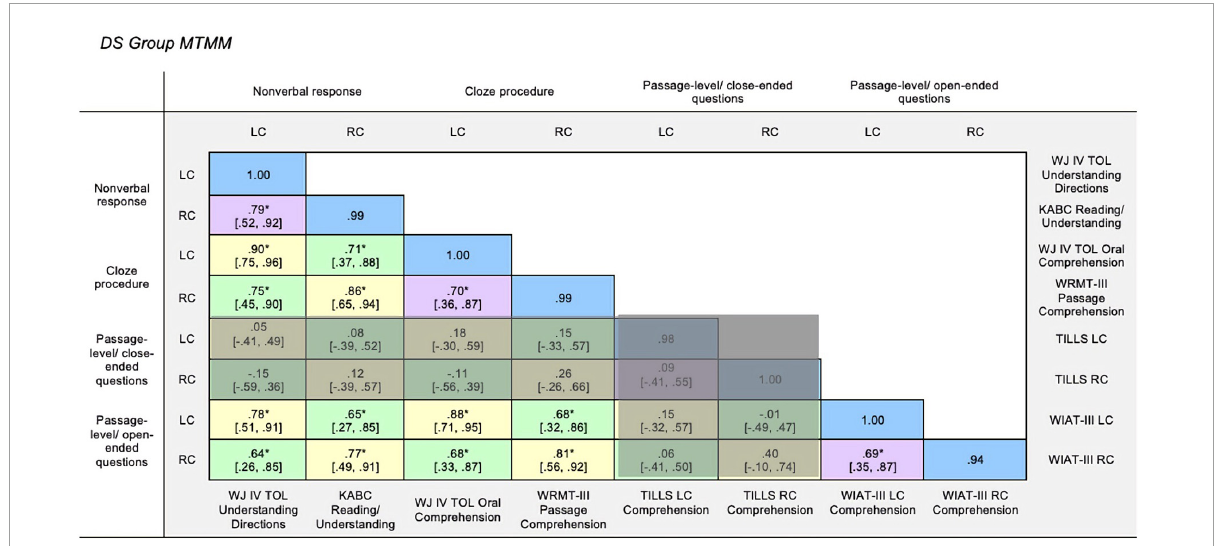
FIGURE1 DS group MTMM. Multitrait-multimethod matrix for Down syndrome group. Monotrait-monomethod cells (reliability diagonal) marked in blue, monotrait-heteromethod cells (validity diagonal) marked in yellow (heterotrait-monomethod cells marked in purple, and heterotrait-heteromethod cells marked in green. LC, Listening Comprehension; RC, Reading Comprehension; WJ IV TOL, Woodcock-Johnson Test of Oral Language IV (Schrank et al., 2014); KABC, Kaufman Assessment Battery for Children (Kaufman and Kaufman, 1983); WRMT-III, Woodcock Reading Mastery Tests-Third Edition (Woodcock, 2011); WIAT-III, Wechsler Individual Achievement Test-Third Edition (Wechsler, 2009). * p >